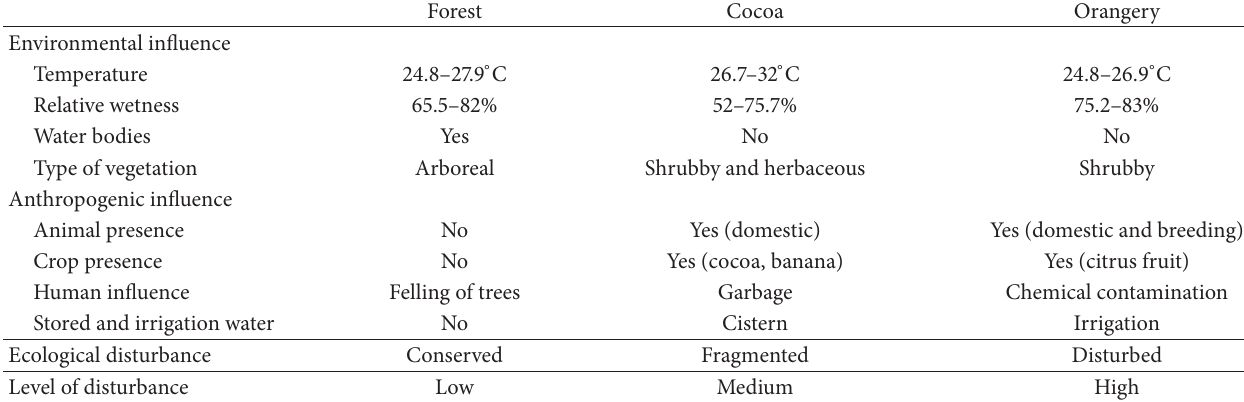
Table 1: Ecoepidemiological characteristics and the degree of disturbance of the agroecosystems.